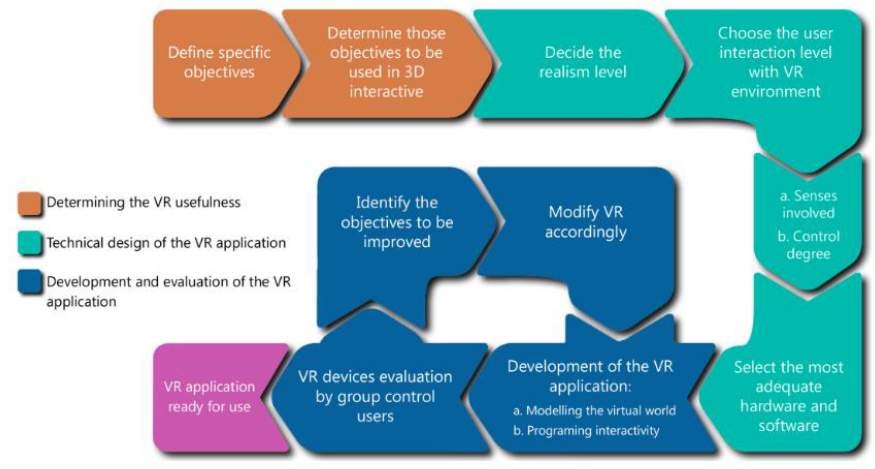
Figure 3. Design process of a VRLE previously described and published elsewhere.